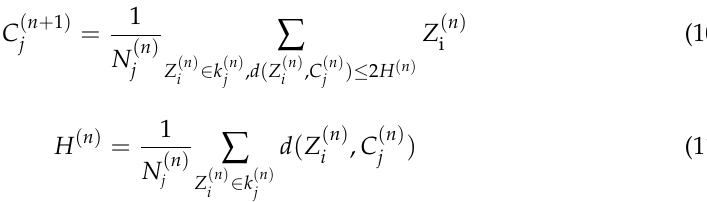
Figure 4. The clustering under different initial center with four clusters.( a ) C = [Z(4,:);Z(16,:); Z(24,:); Z(37,:)]; ( b ) C = [Z(4,:);Z(24,:);Z(25,:);Z(37,:)]. Z(n,:) represents the nth data in dataset Z.